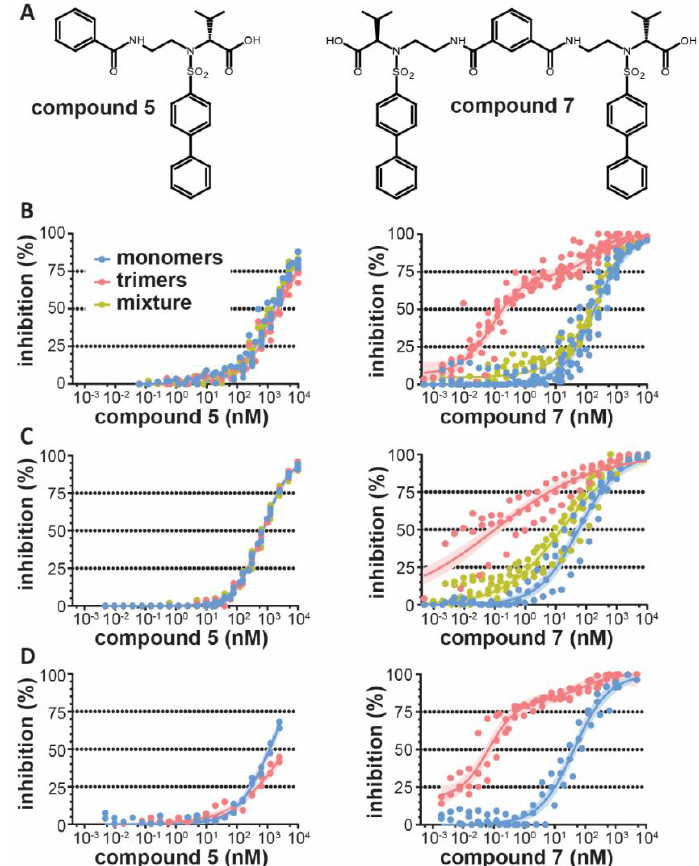
Figure 1. Inhibition of matrix metalloproteinase (MMP)-9-mediated proteolysis by monovalent and bivalent carboxylate inhibitors. ( A ) Chemical structure of the monovalent (compound 5 , left) and the corresponding bivalent (compound 7 , right) carboxylate inhibitors [26]; ( B ) inhibition of gelatinolytic activity of recombinant human MMP-9 monomers, trimers and their mixture (± 70% monomers and ± 30% trimers) by the monovalent inhibitor (left panel) and bivalent inhibitor (right panel); ( C ) inhibition of peptidolytic activity of recombinant human MMP-9 monomers, trimers and their mixture (± 70% monomers and ± 30% trimers) by the monovalent inhibitor (left panel) and bivalent inhibitor (right panel); ( D ) inhibition of gelatinolytic activity of human neutrophil-derived MMP-9 monomers or trimers by the monovalent inhibitor (left panel) and bivalent inhibitor (right panel). Data were fitted with either a standard or biphasic dose-response fit, as indicated in Table 1. Surface area fill represents the 95% confidence interval of the fit.